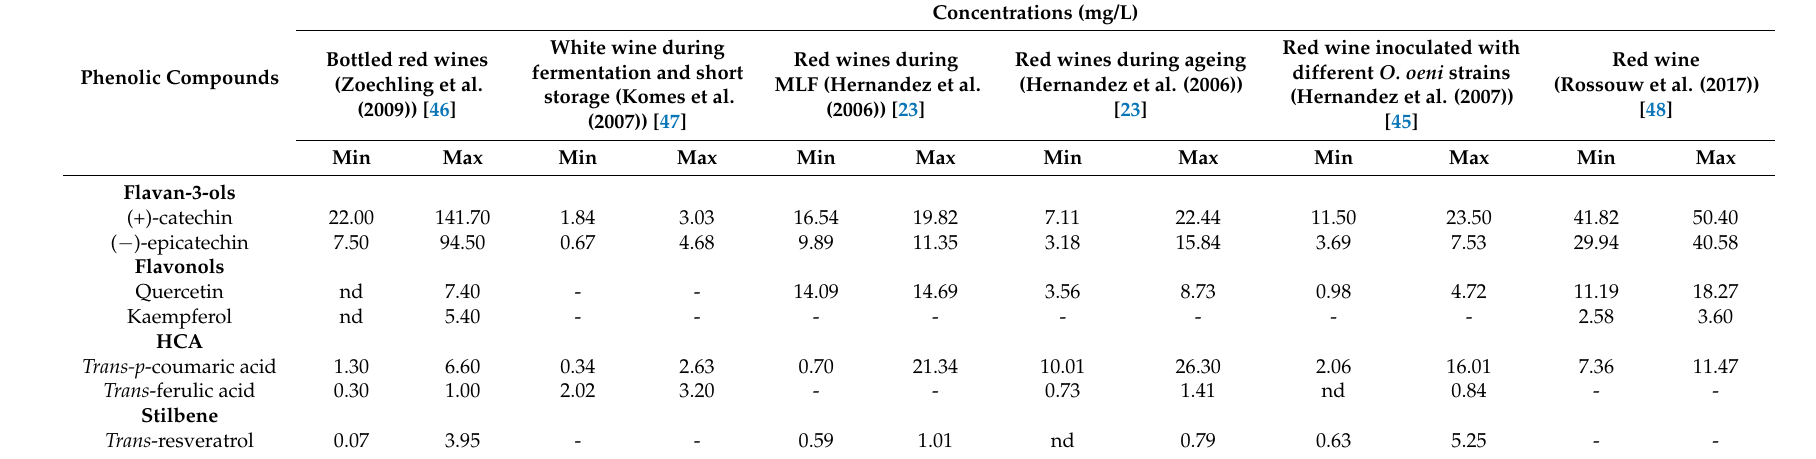
Table 4. Minimal and maximal concentrations (mg/L) in phenolic compounds in wines (during alcoholic fermentation, MLF, ageing, and in bottles) as reported in the literature